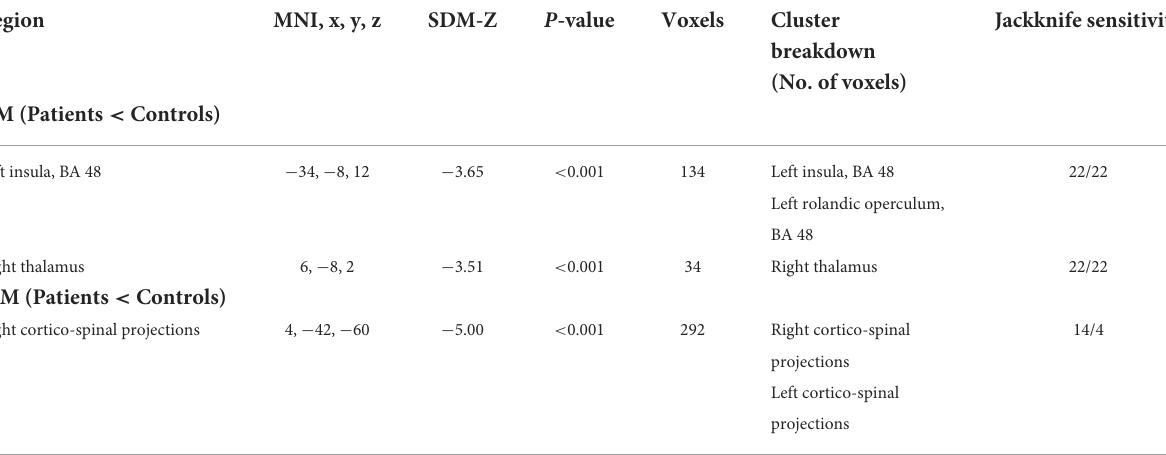
TABLE 2 Regional differences in gray matter and white matter volume between SCI patients and healthy controls. Region MNI, x, y, z